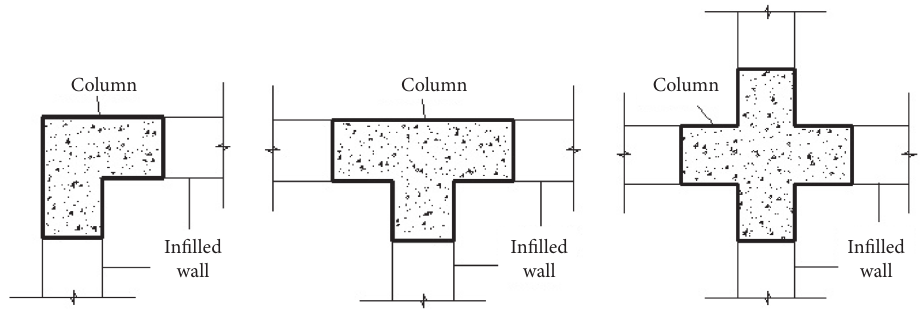
Figure 1: Joints in frame structure with special-shaped